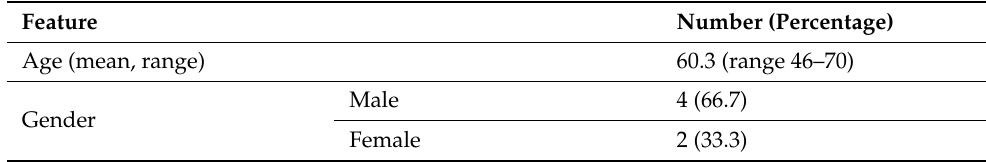
Table 1. Demographic and clinical features of the patients enrolled in the